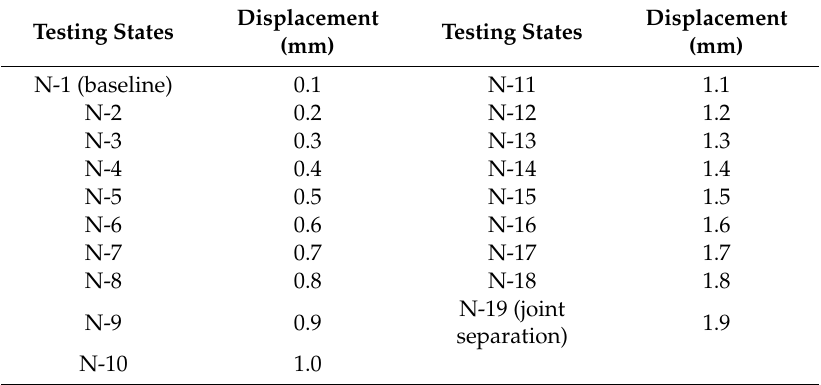
Table 3. Testing states in tensile experiment.